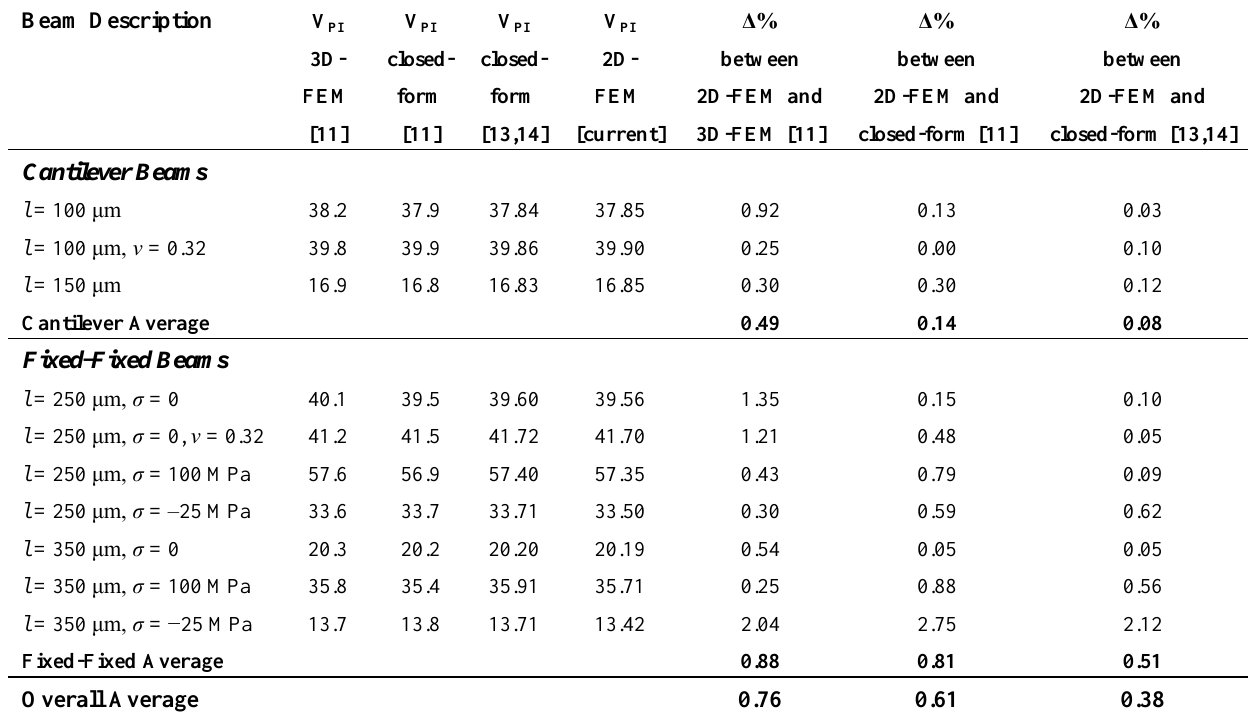
Table 2. Comparison of 2D finite element analysis with results presented in [11,13,14]. closed- closed- 2D- between between between